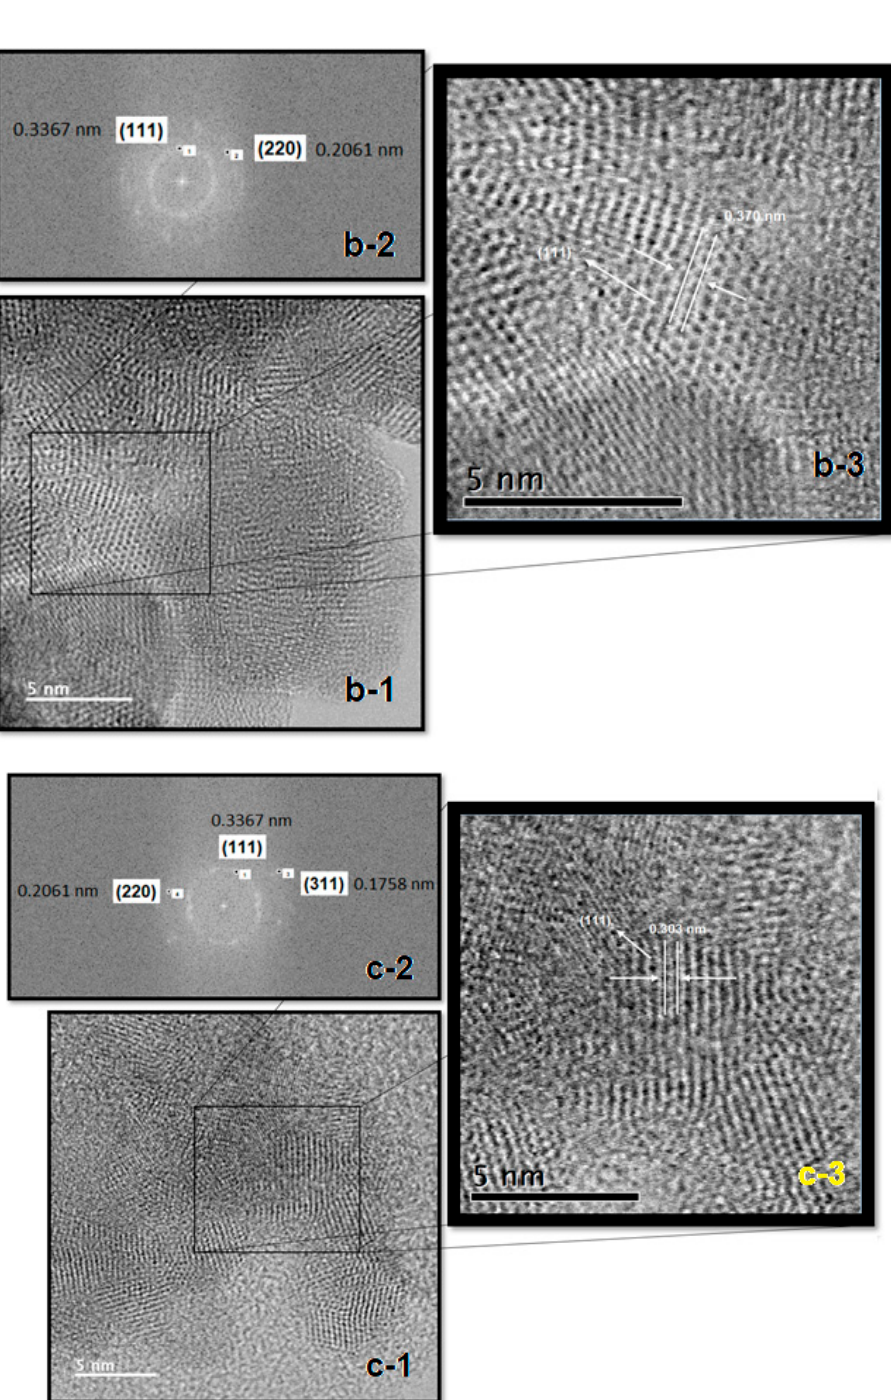
Figure 5. HRTEM patterns of Zn 0.1 Cd 0.9 S ( b , c ) and Zn 0.2 Cd 0.8 S solid solutions. Diameters of the crystallites ( b-1 ), ( c-1 ), Cd 0.9 Zn 0.1 S ( b-2 ), Cd 0.8 Zn 0.2 S ( c-2 ), the cubic phase of the CdS ( b-3 ), ( c-3 ).